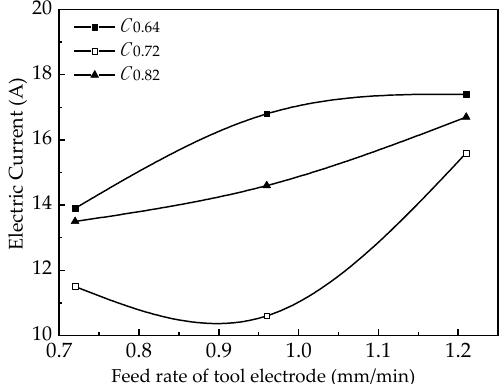
Figure 16. Electric-current sampling of ECM.